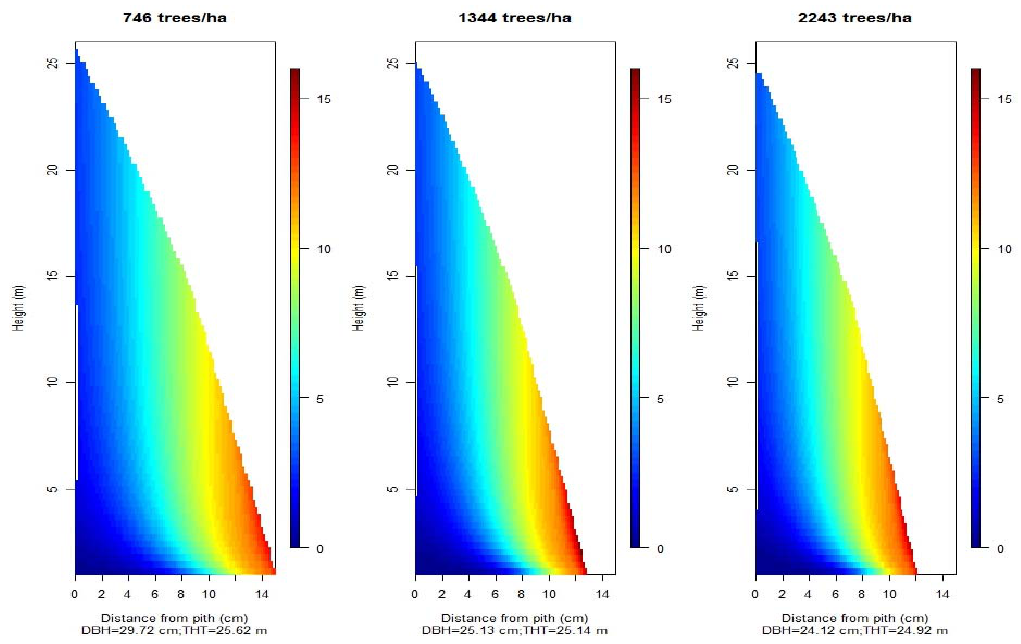
Figure 4. Maps showing within-tree variation in stiffness (GPa) of loblolly pine for a tree with average diameter at breast height, and total height, planted at three initial planting densities. The maps were produced based on predictions from a model by Antony et al. [51]. DBH: diameter at breast height; THT: tree height.